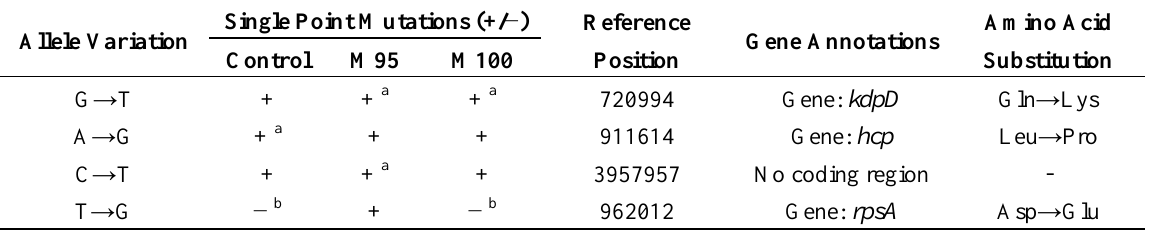
Table 3. Single point mutations identified in the Control, M95 and M100 when assembled with the E. coli U00096 reference